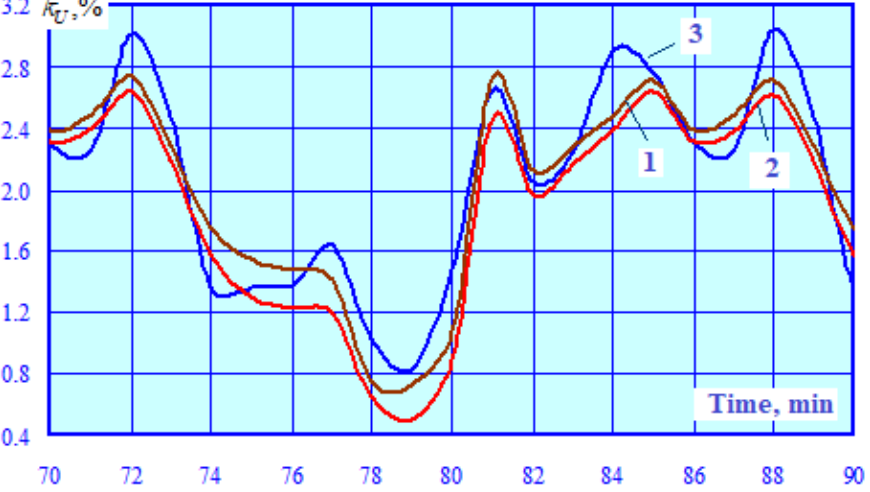
Figure 11. Total harmonic distortion values at 220 kV buses of TP 4, phase C—callout numbers correspond to those in Figure 6.